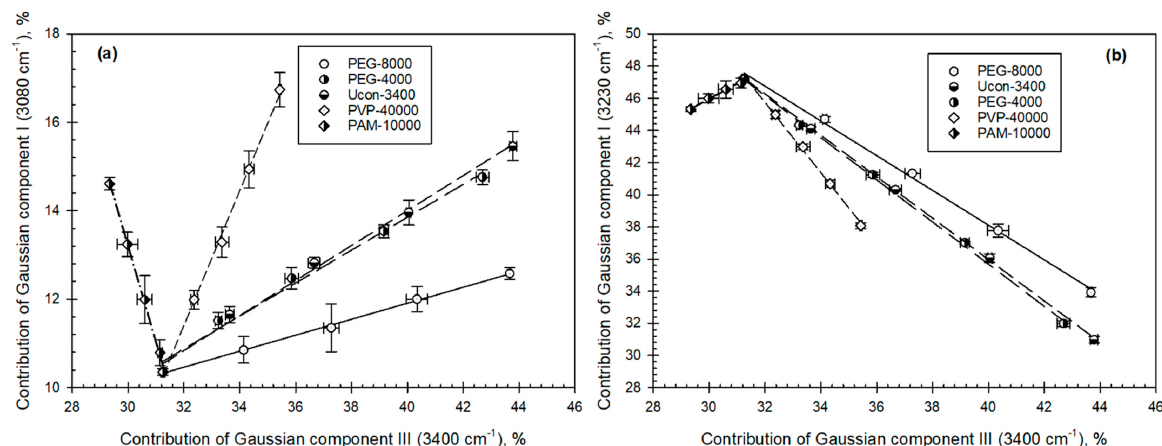
Figure 6. ( a , b ). Relationships between ( a ) contributions of Gaussian component I (I 3080 cm − 1 ) and III (I 3400 cm − 1 ) and ( b ) contributions of Gaussian component II (I 3230 cm − 1 ) and III (I 3400 cm − 1 ) in aqueous solutions of individual polymers indicated over the concentration range of 0–40% wt.